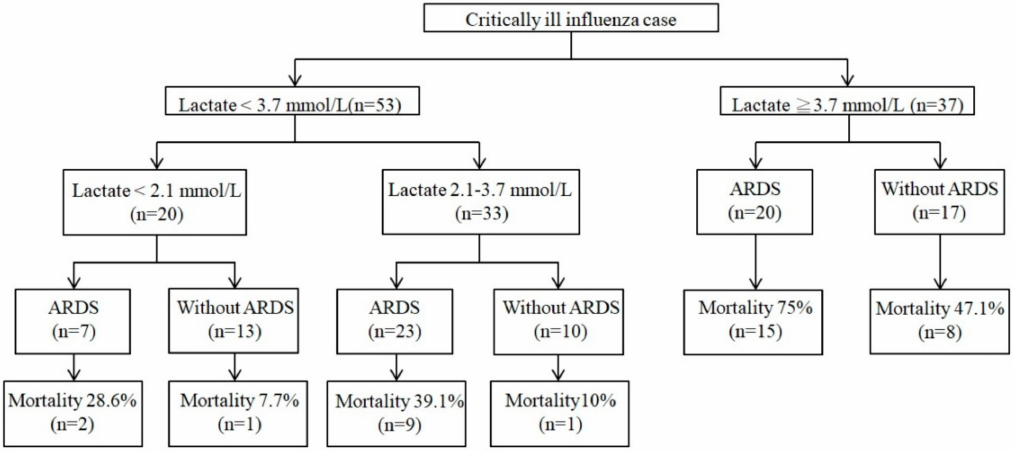
Figure 1. Receiver operating characteristic curve of lactate for prediction of mortality.